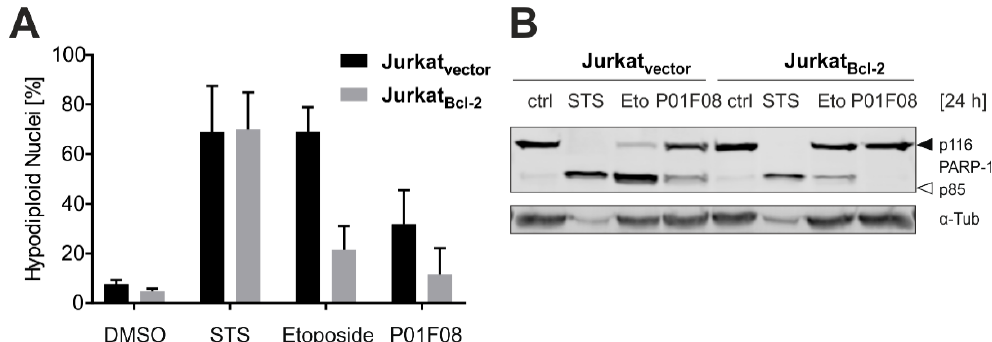
Figure 9. P01F08 induces Bcl-2 dependent apoptosis. Jurkat cells overexpressing Bcl-2 and corresponding vector control cells were treated with 2.5 µM staurosporine (STS), 50 µM Etoposide, and 10 µM P01F08 for 24 h. ( A ) Apoptosis-related DNA degradation was detected via flowcytometric measurement of propidium iodide stained hypodiploid nuclei. Mean and SD of three independent experiments performed in triplicates are depicted. ( B ) Representative immunoblot of three independent experiments of cleavage of the caspase-3 substrate poly(ADP-ribose) polymerase 1 (PARP1; full-length 116 kDa, cleaved form 85 kDa) as an indicator for apoptotic cell death. anti-Tubulin ( α -Tub) served as a loading control.